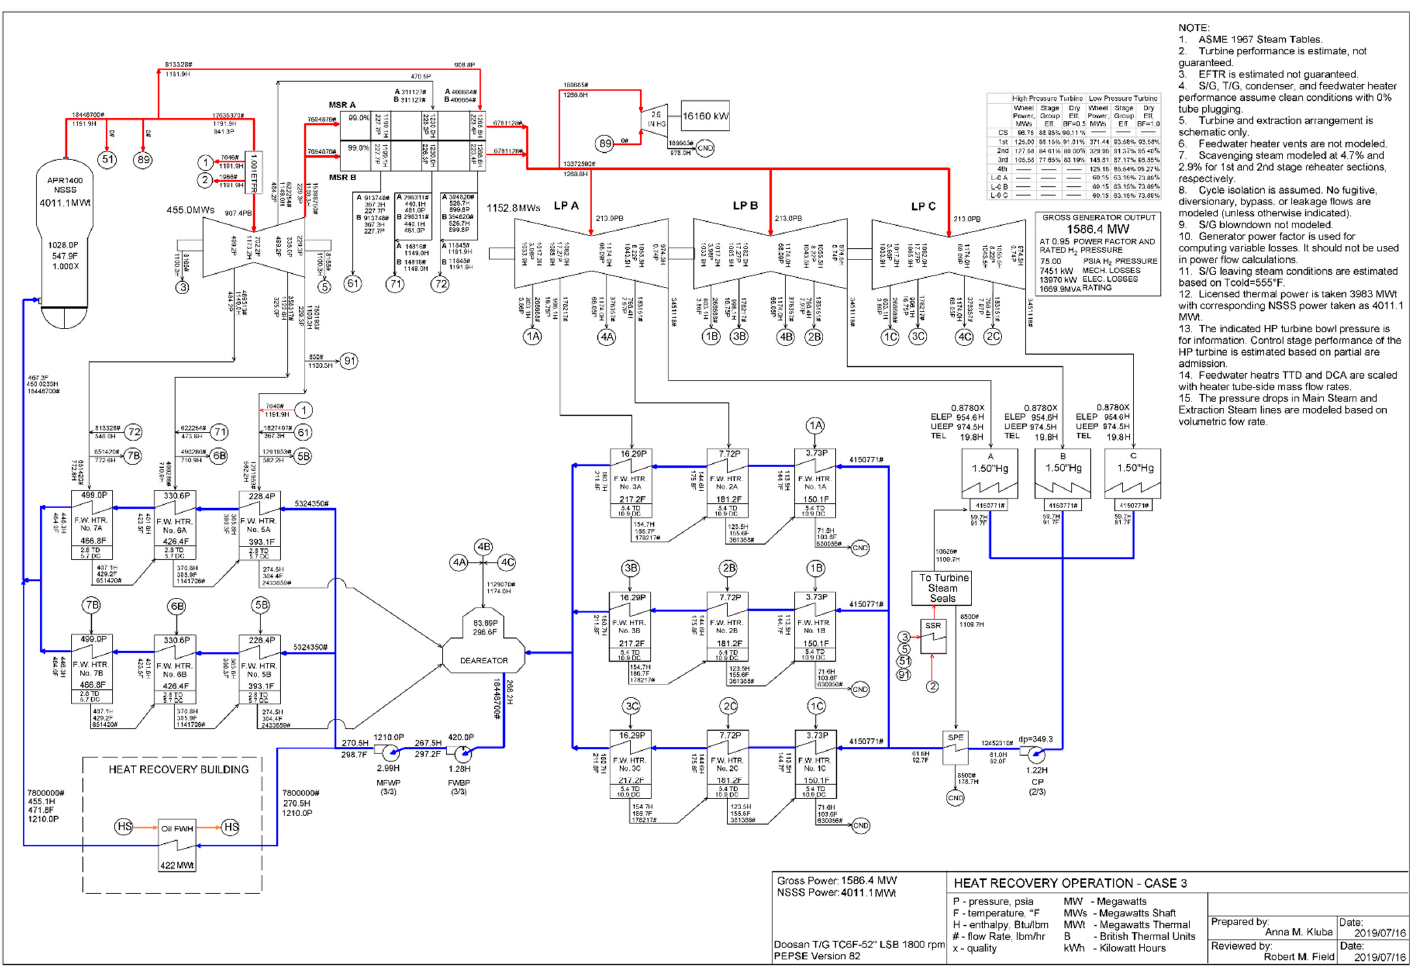
Figure A2. APR1400 NHS&R heat balance diagram under heat recovery operation—Case 3 (PEPSE TM results). The abbreviations are explained in the Abbreviations List.